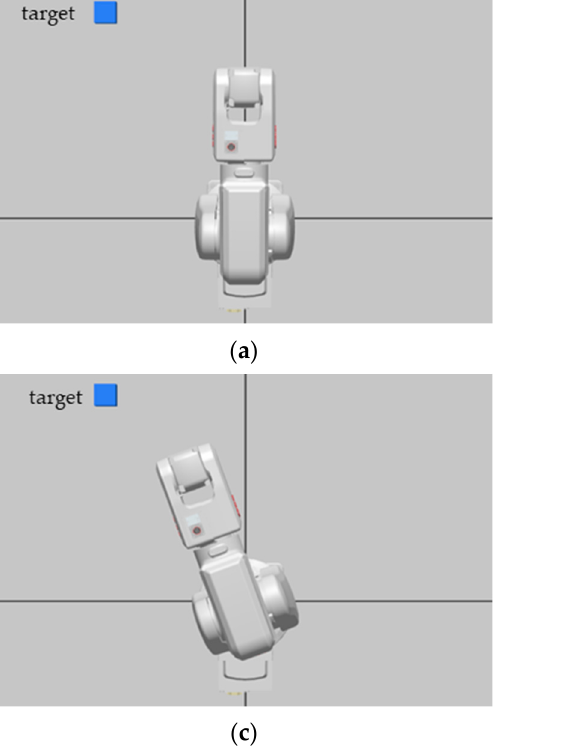
movement. ( d ) right